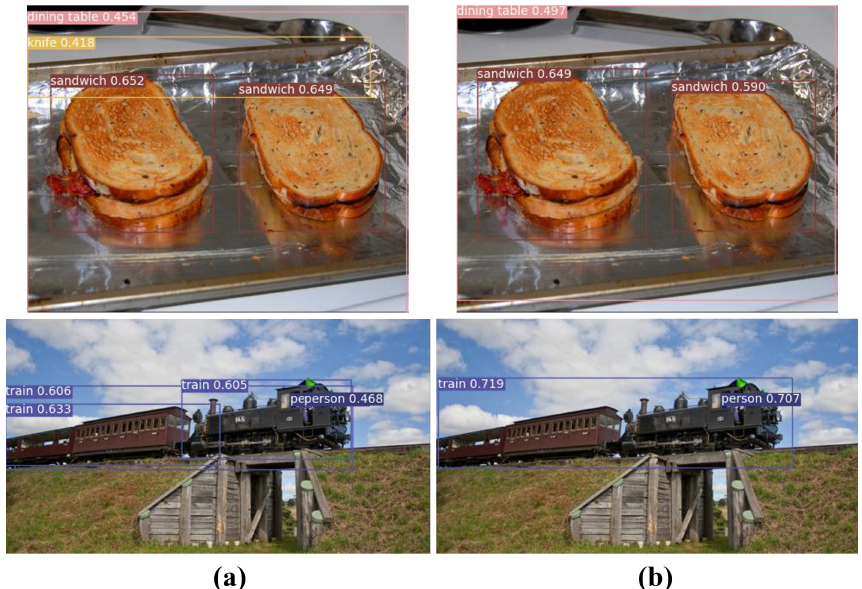
Figure 8. Comparison of detection results of MSCOCO 2017 minival dataset. ( a ) FCOS and ( b ) HISF- COS. As in the image below, the proposed method could effectively detect large